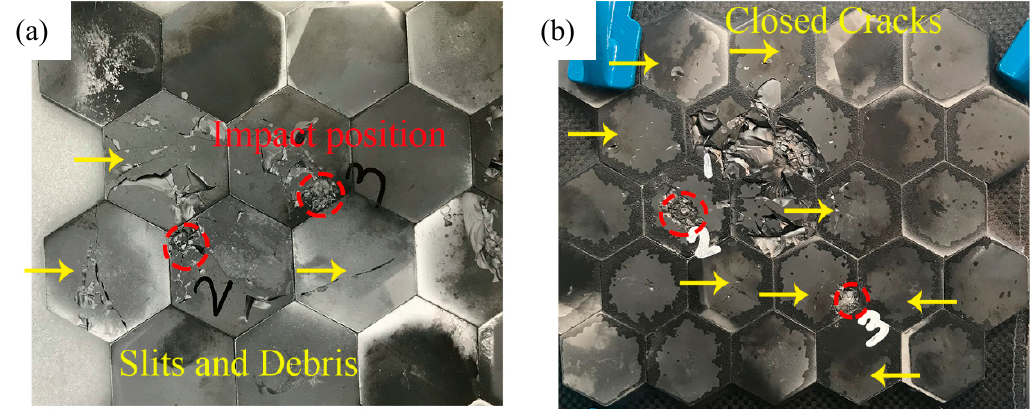
Figure 5. Ceramic damage morphology after the third penetration: ( a ) Structure 1; ( b ) Structure 3.